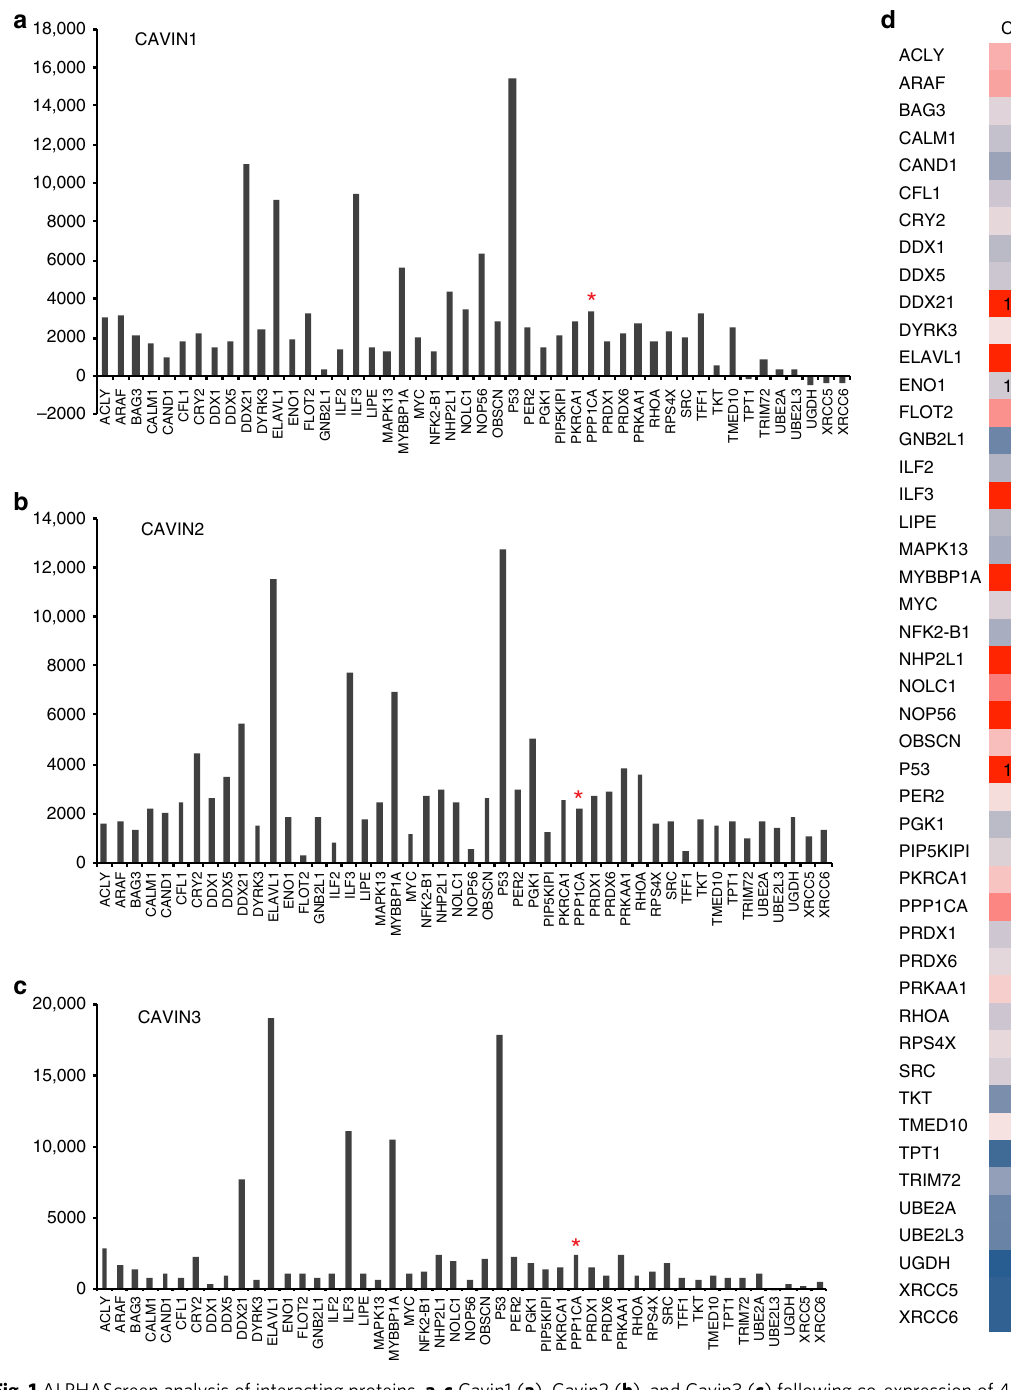
Fig. 1 ALPHAScreen analysis of interacting proteins. a – c Cavin1 ( a ), Cavin2 ( b ), and Cavin3 ( c ) following co-expression of 47 potential interacting proteins in the eukaryotic Leishmania tarentolae -based cell-free-expression system. Each protein pair was tested in triplicate and values above 2000 counts were considered positive interactions. Red = positive interactions, blue = no interactions. *PPP1CA serine/threonine-protein phosphatase PP1alpha catalytic subunit. d Interaction heatmap of the mean values of 47 tested potential interacting proteins with each of Cavin1, Cavin2, and Cavin3 from three independent